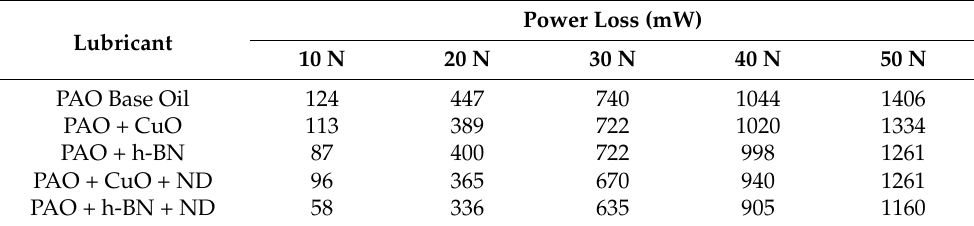
Table 6. Power loss (mW) due to sliding under lubrication with PAO base oil and the four nanolubri- cants at all